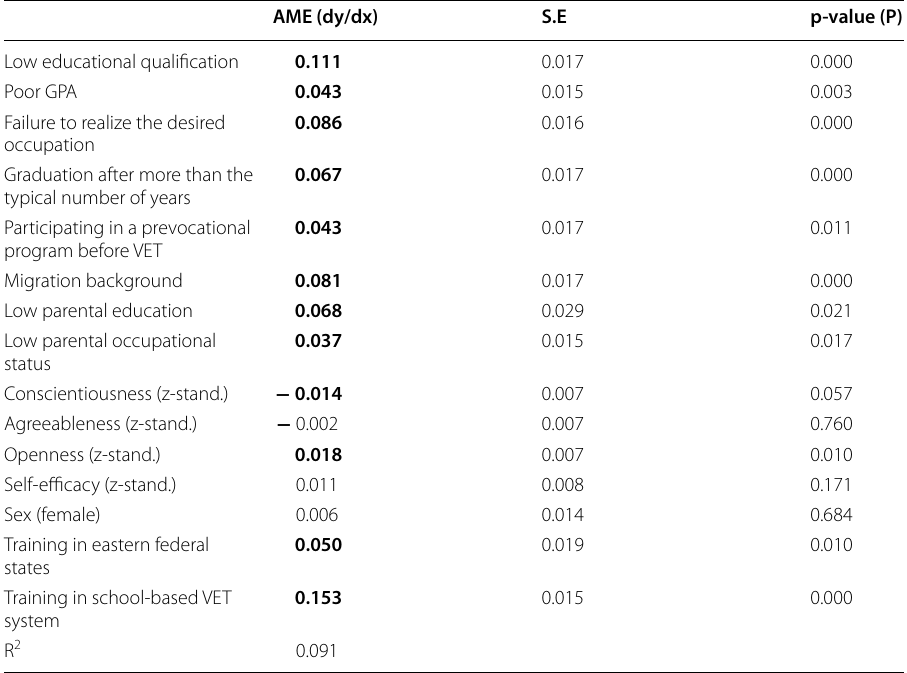
Reference group: Successful in first VET program; n in bold